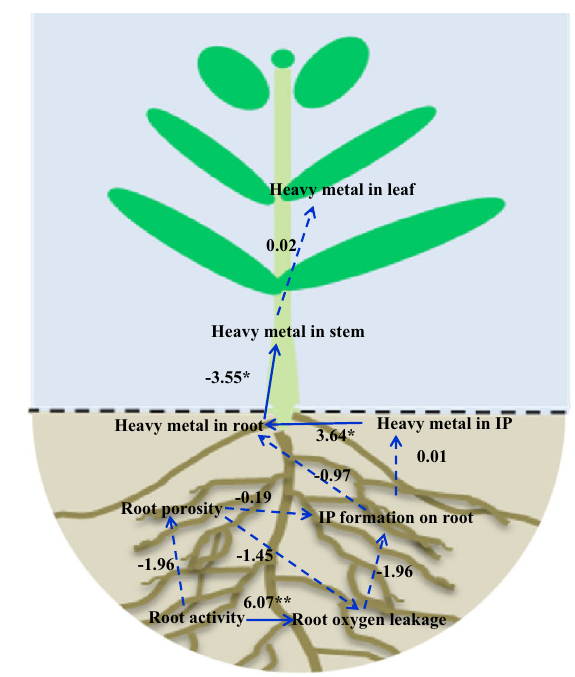
Figure 4. Relationships among root responses, IP formation, and heavy metal bioaccumulation based on RPA. Solid and dashed lines represent the direct and indirect impact, respectively. * P < 0.05. ** P <